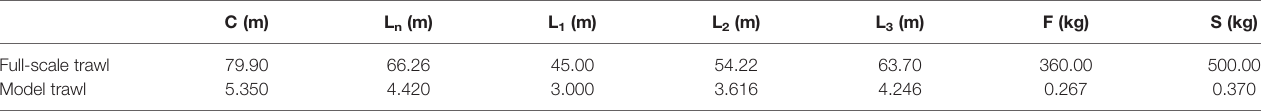
TABLE 1 | Main speci fi cations and parameters of the full-scale trawl and model trawl. C (m) L n (m) Full-scale